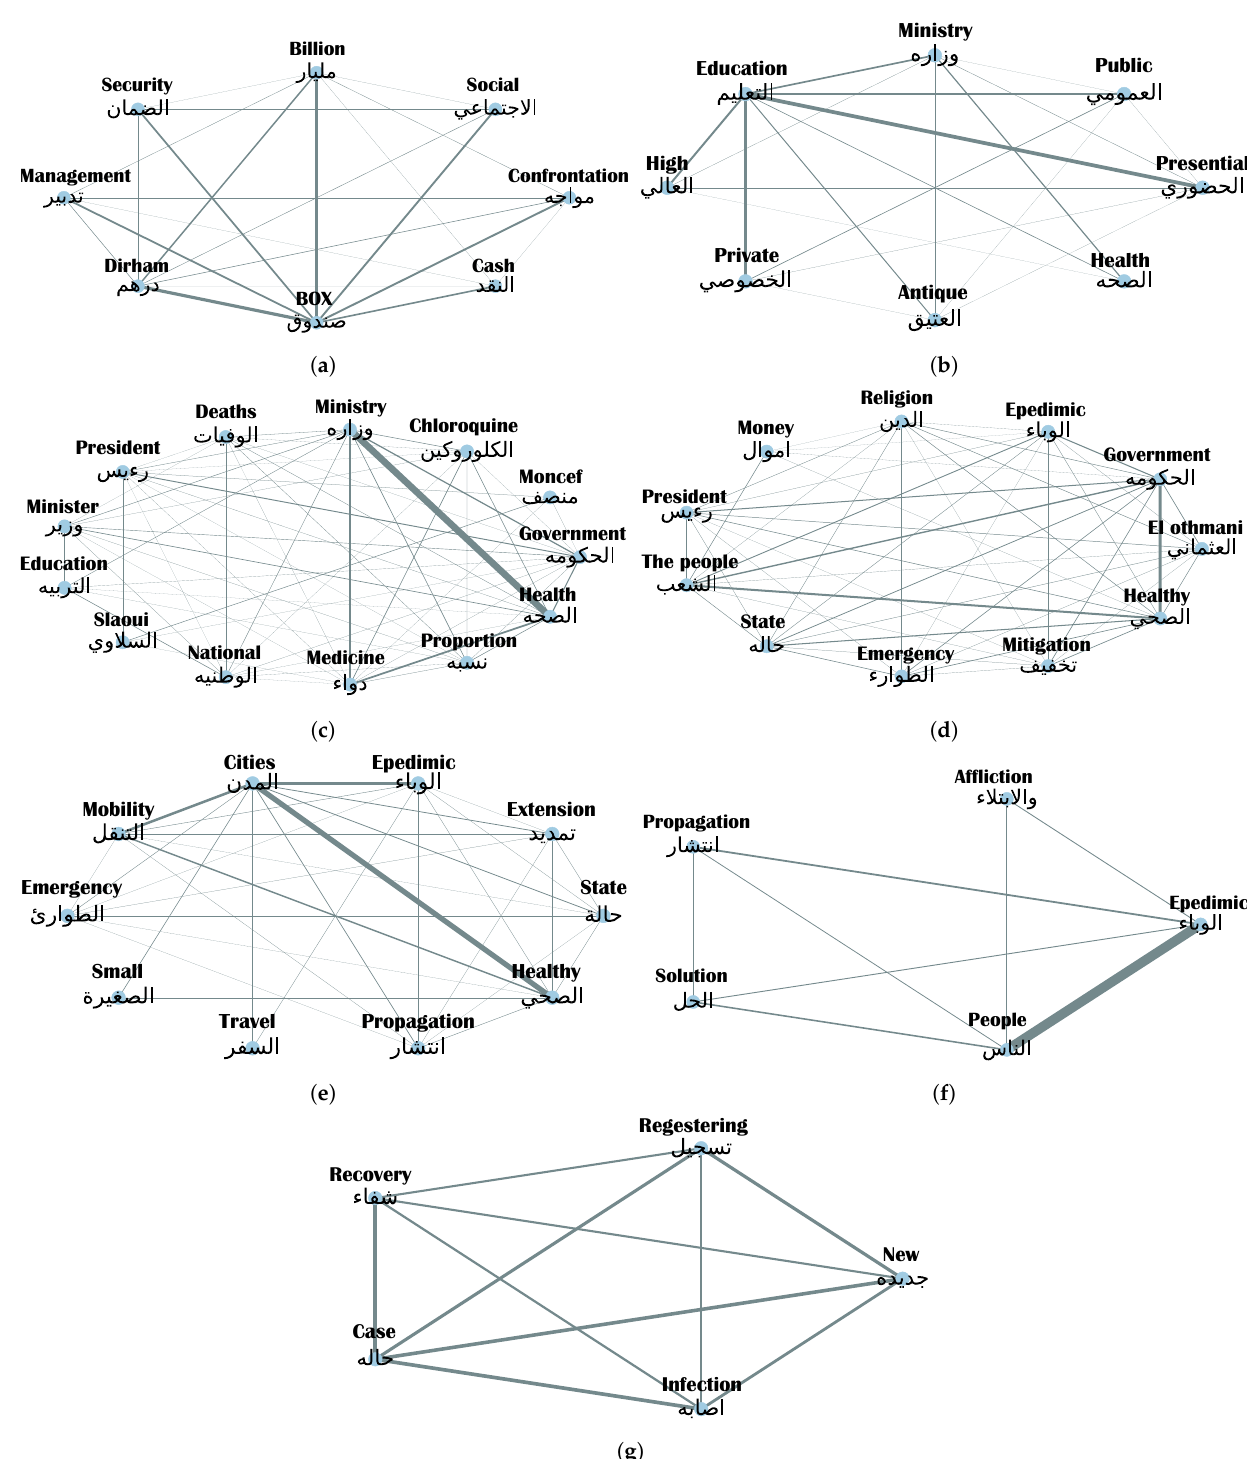
Figure 9. Connections between the most dominant words in COVID-related communications in Moroccan social media. Thicker lines correspond to higher co-occurrences. ( a ) Connections between the most dominant words for ‘Economy’ related communications. ( b ) Connections between the most dominant words for ‘Education’ related communications. ( c ) Connections between the most dominant words for ‘Health’ related communications. ( d ) Connections between the most dominant words for ‘Government’ related communications. ( e ) Connections between the most dominant words for ‘Sanitary Measures’ related communications. ( f ) Connections between the most dominant words for ‘Social Life’ related communications. ( g ) Connections between the most dominant words for ‘Statistics’ related